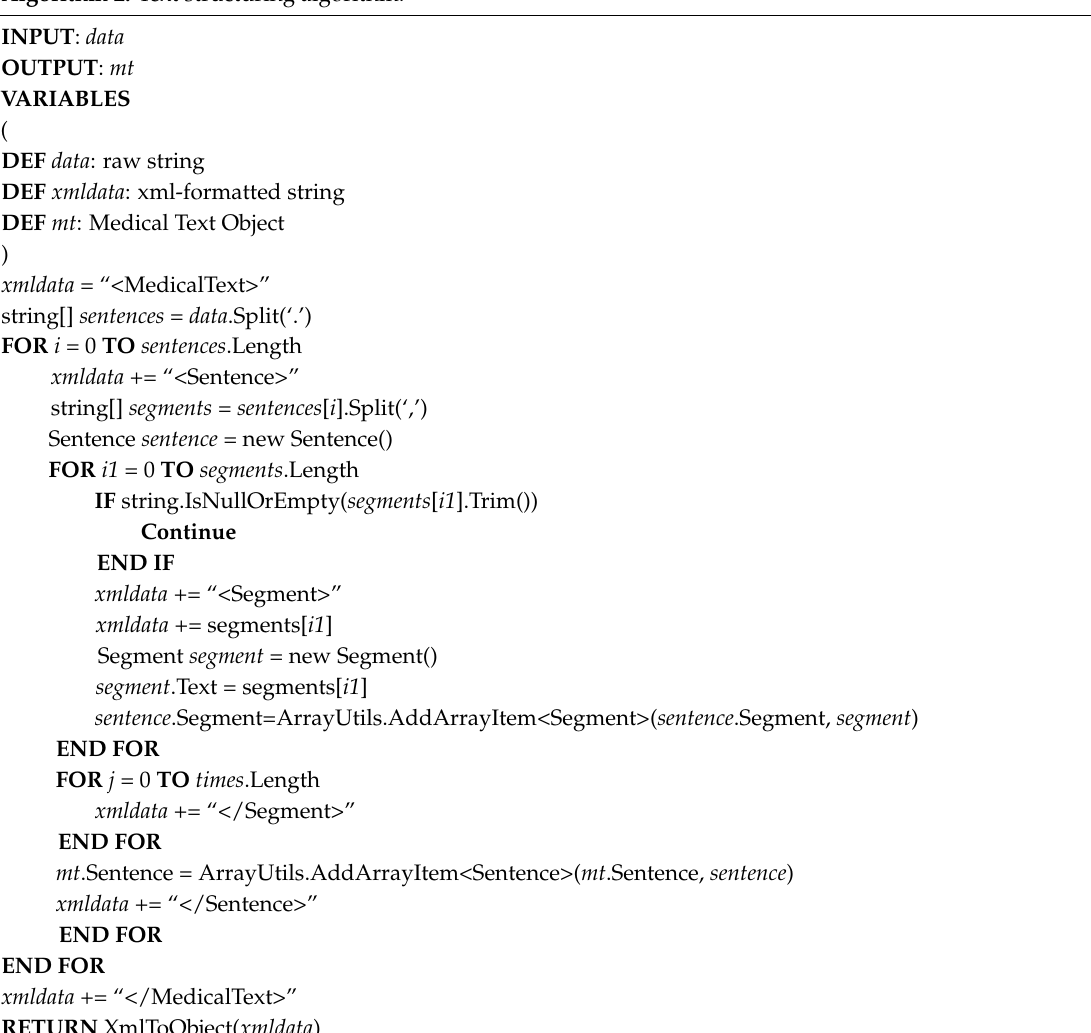
Algorithm 2. Text structuring